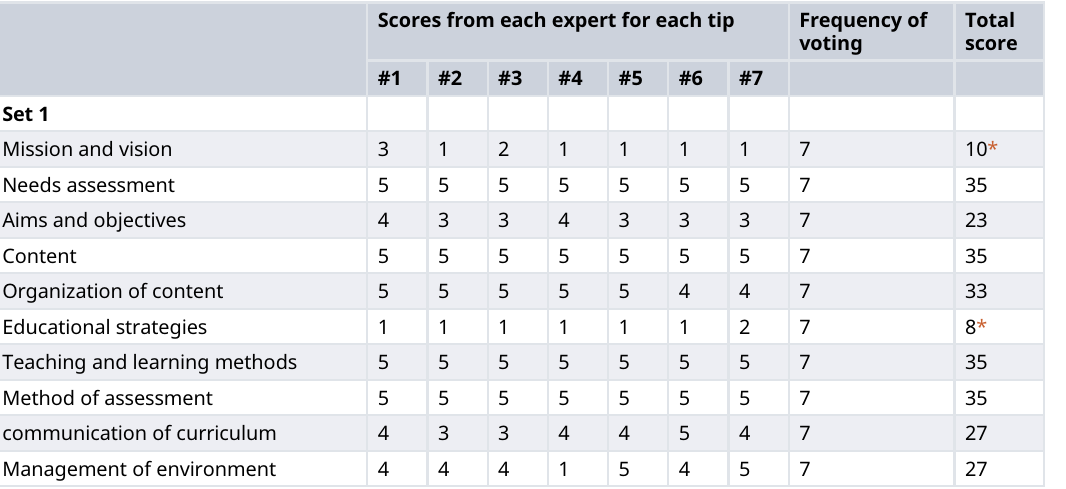
Table 2. Scoring by experts for each set of guidelines.